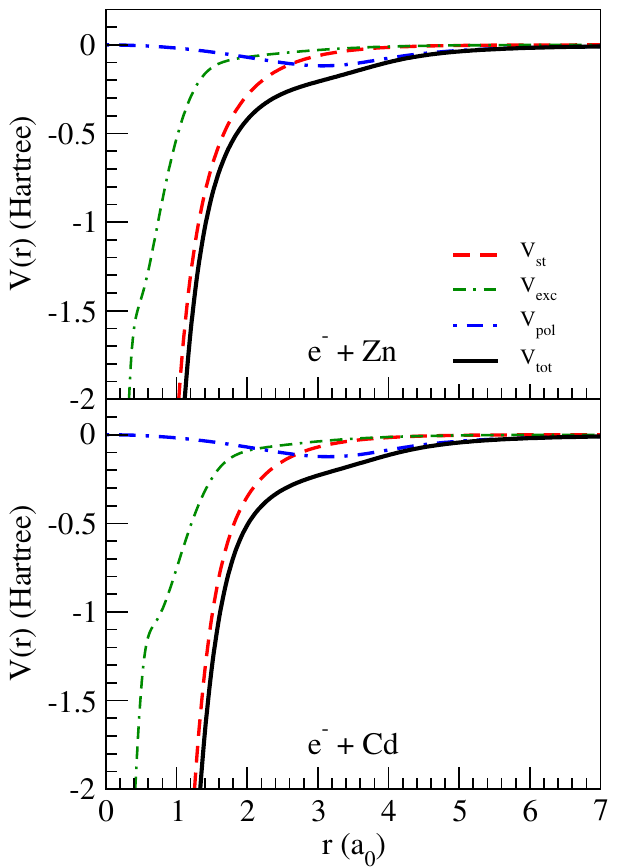
Figure 2. Electron–Zn ( upper ) and electron–Cd ( bottom ) scattering potentials. Legends are in the